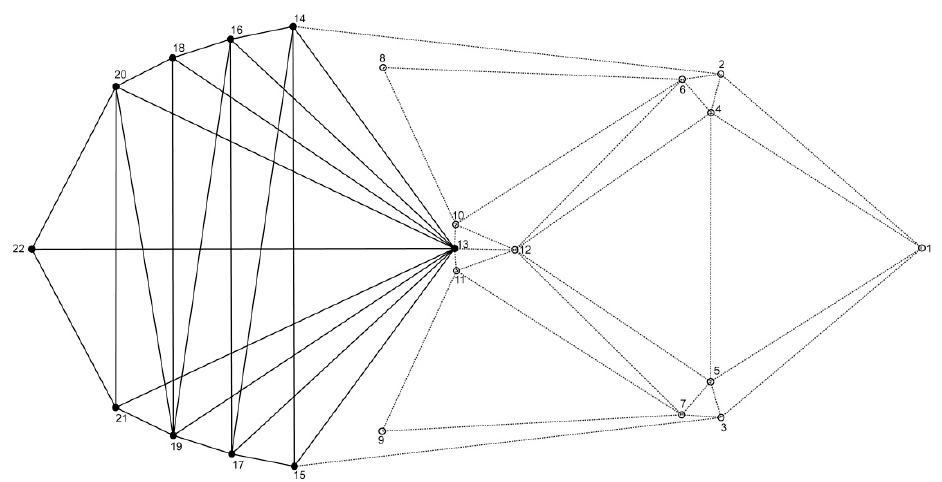
Figure 4. A priori hypothesis of a two-module (thorax—dashed line, abdomensol—id line) organization of female and male seed beetles.